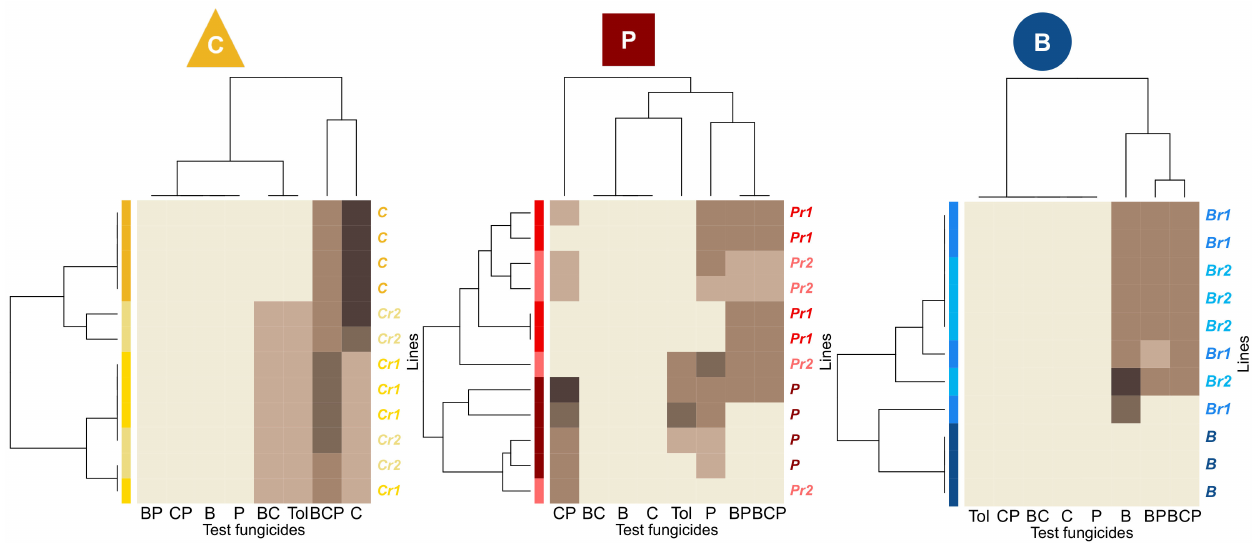
Figure 4. Heatmaps of phenotypic resistance profiles at cycle 9. The resistance rating scores (represented by the brown scale: from beige = 0 to dark brown = 4) are shown for each of the 12 lines evolved under three possible selection doses of single-AI treatments (4 replicate lines per dose) and for each fungicide or mixture tested. From left to right, the single AI used is B (benzovindiflupyr; SDHI), C (carbendazim; benzimidazoles) and P (prothioconazole-desthio; DMI). Heatmaps were established with the pairwise Euclidean